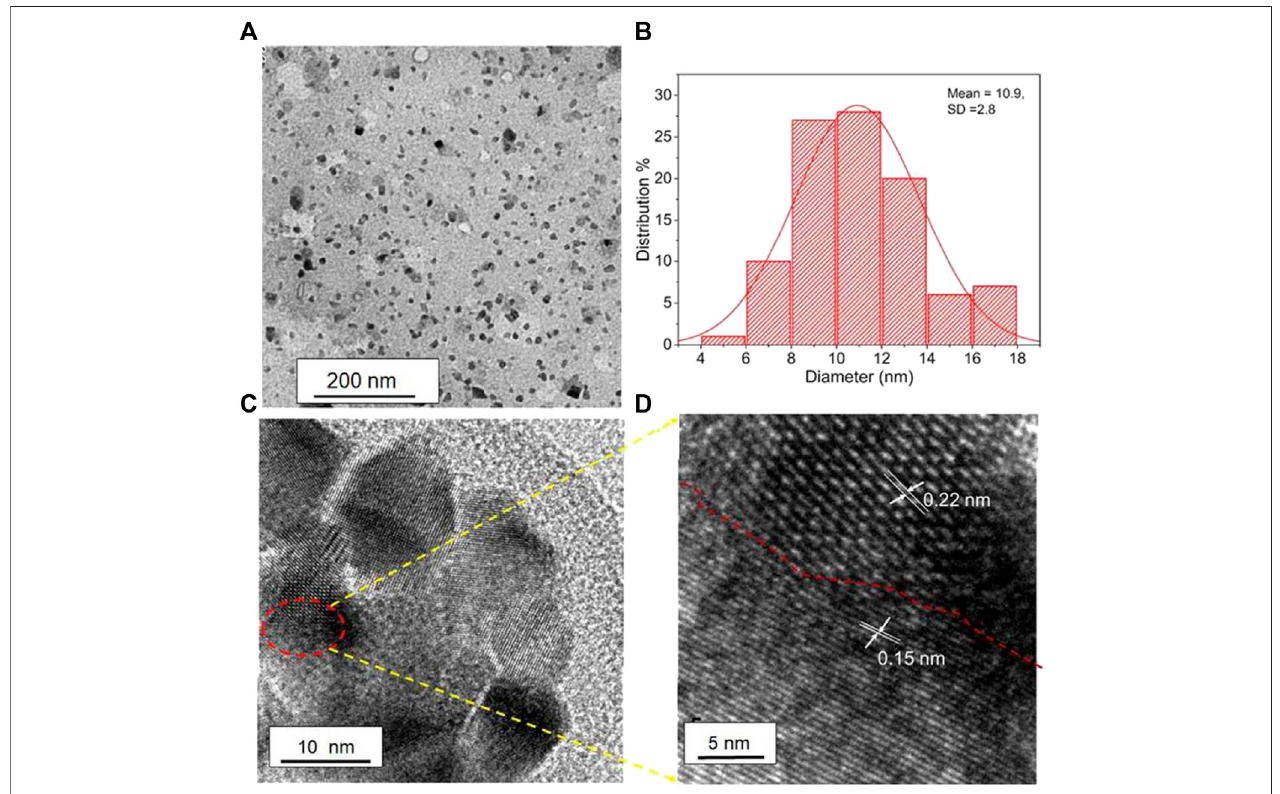
FIGURE 4 | Different magni fi cation (A) TEM image of r-Mg-N-CD and (B) its corresponding size distribution; (C) HRTEM image of r-Mg-N-CD and (D) zoomed image of (C) . (Reproduced with permission from Bhati et al., 2018, Copyright © 2018, American Chemical Society).